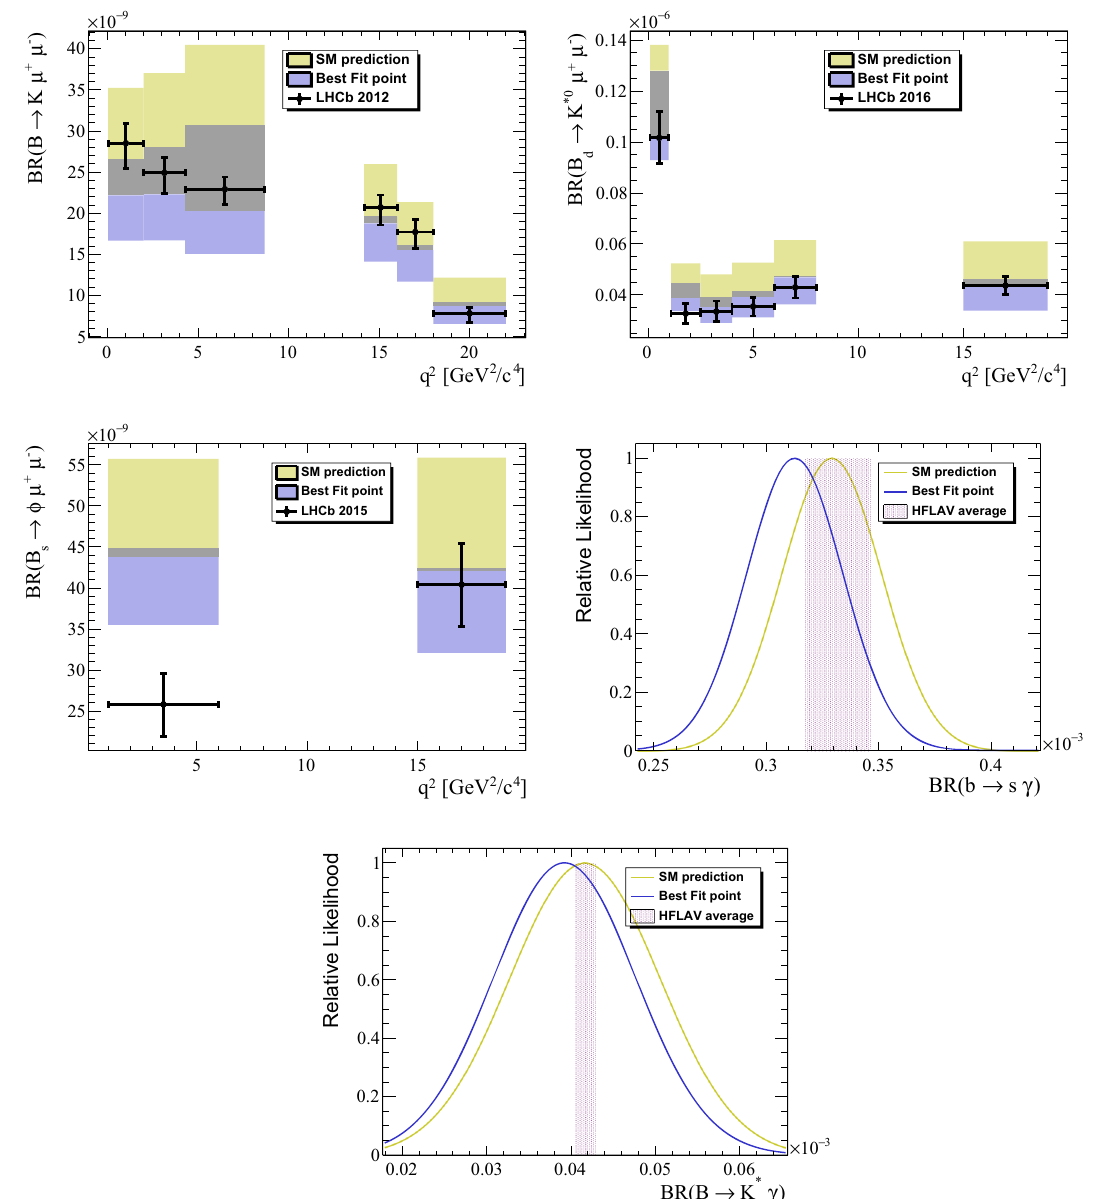
Fig. 4 Branchingfractionsfor b → s transitionsincludedinourfit.Yel- low shading corresponds to Standard Model predictions and uncertain- ties, and blue shading shows the prediction of our best-fit model. Data